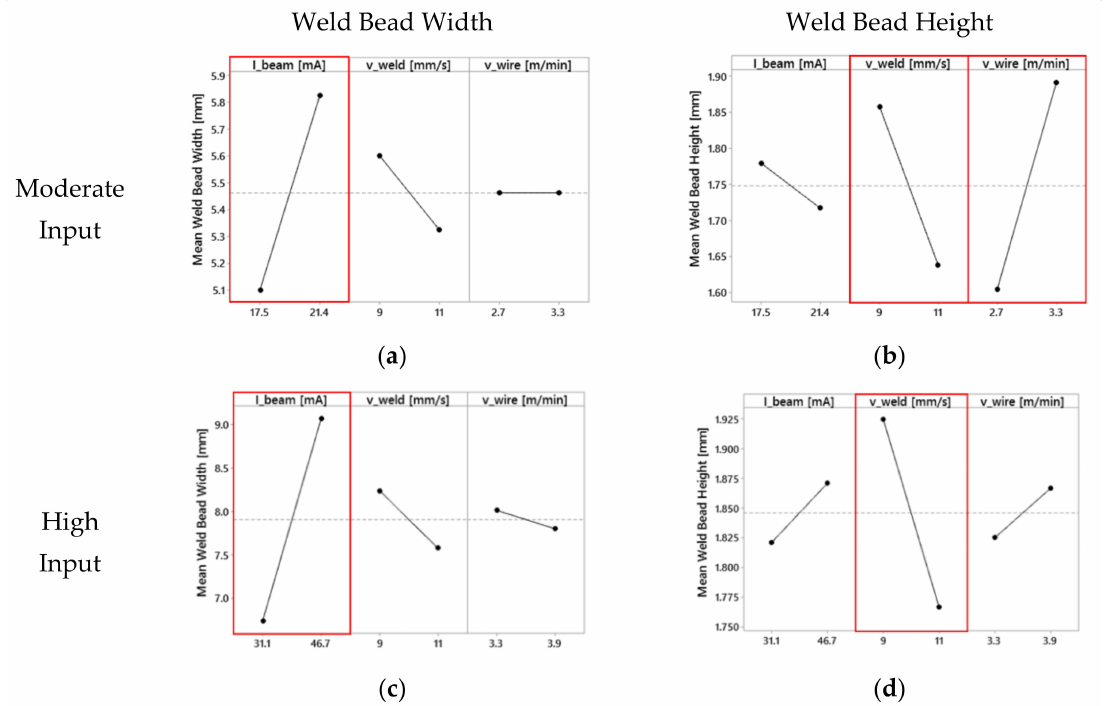
Figure 2. DOE analysis: Influence of process parameters on the weld bead geometry at ( a , b ) moderate and ( c , d ) high input, and related significant process parameters are framed